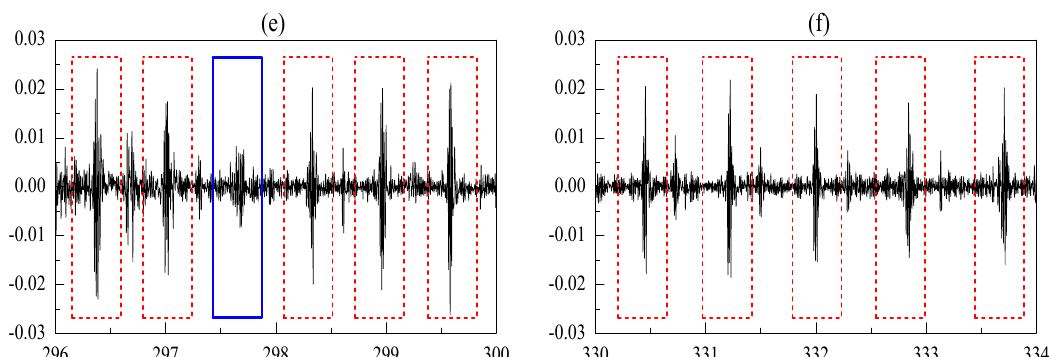
Figure 10. ( a – f ) Segmented signal during standing before walking, transitions from standing to walking, the first half of walking, the second half of walking, transitions from walking to standing, standing after walking. (The x -axis and y -axis are time in seconds and acceleration in gravity respectively.)